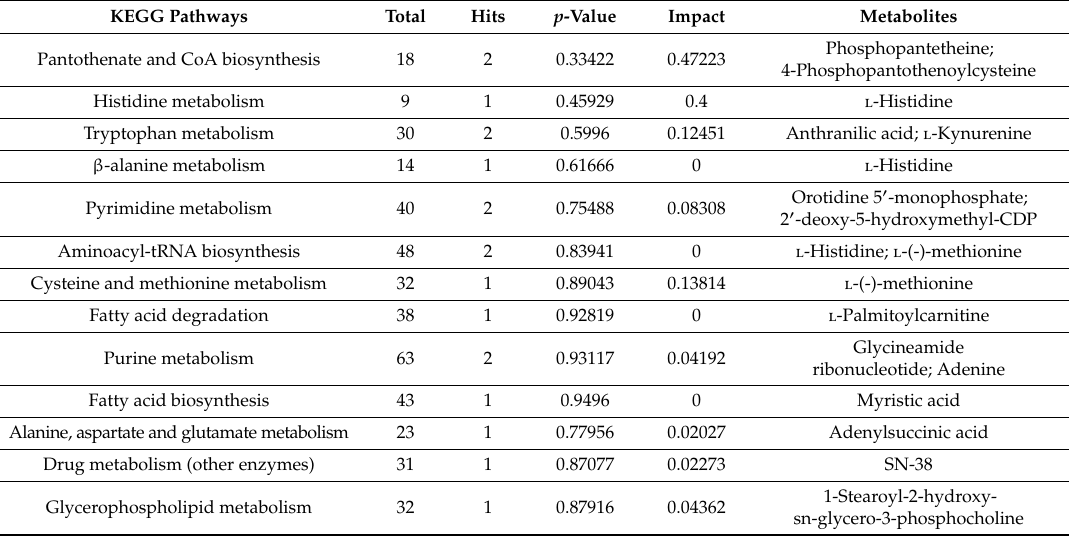
Table 2. The statistics of the KEGG enrichment of the di ff erential